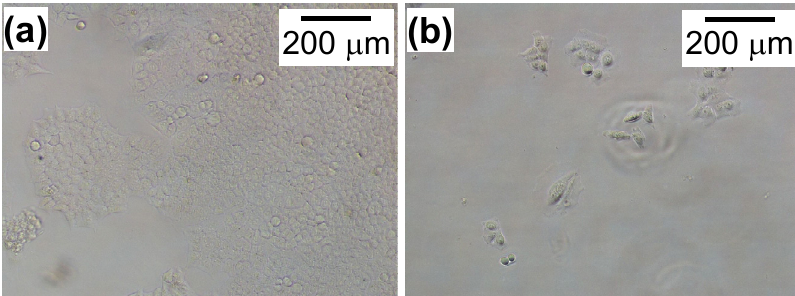
Figure 2. Images of HeLa cells without ( a ) and with ( b ) a CH11 antibody at 1.0 μ g/mL. There were fewer cells after adding this antibody compared with those without this